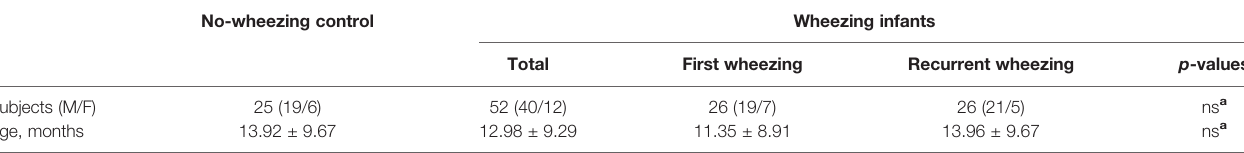
TABLE 2 | Characteristics of cases and control from Xiangya Hospital and Hunan Children ’ s